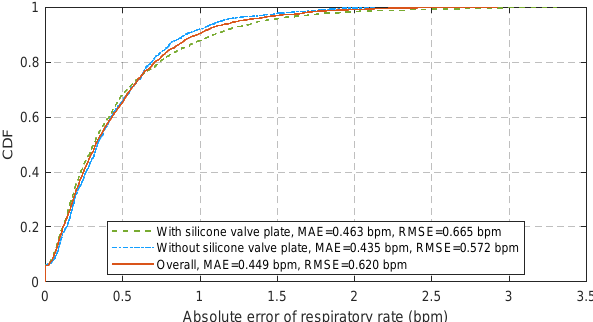
Figure 15. The Pearson’s correlation (left) and the Bland–Altman (right) plots of respiratory rates measured at 180 ms period.